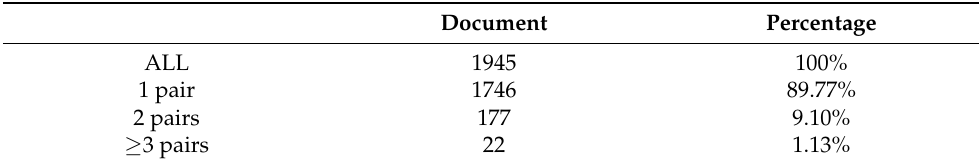
Table 1. Statistics on the number of emotion-cause pairs in the